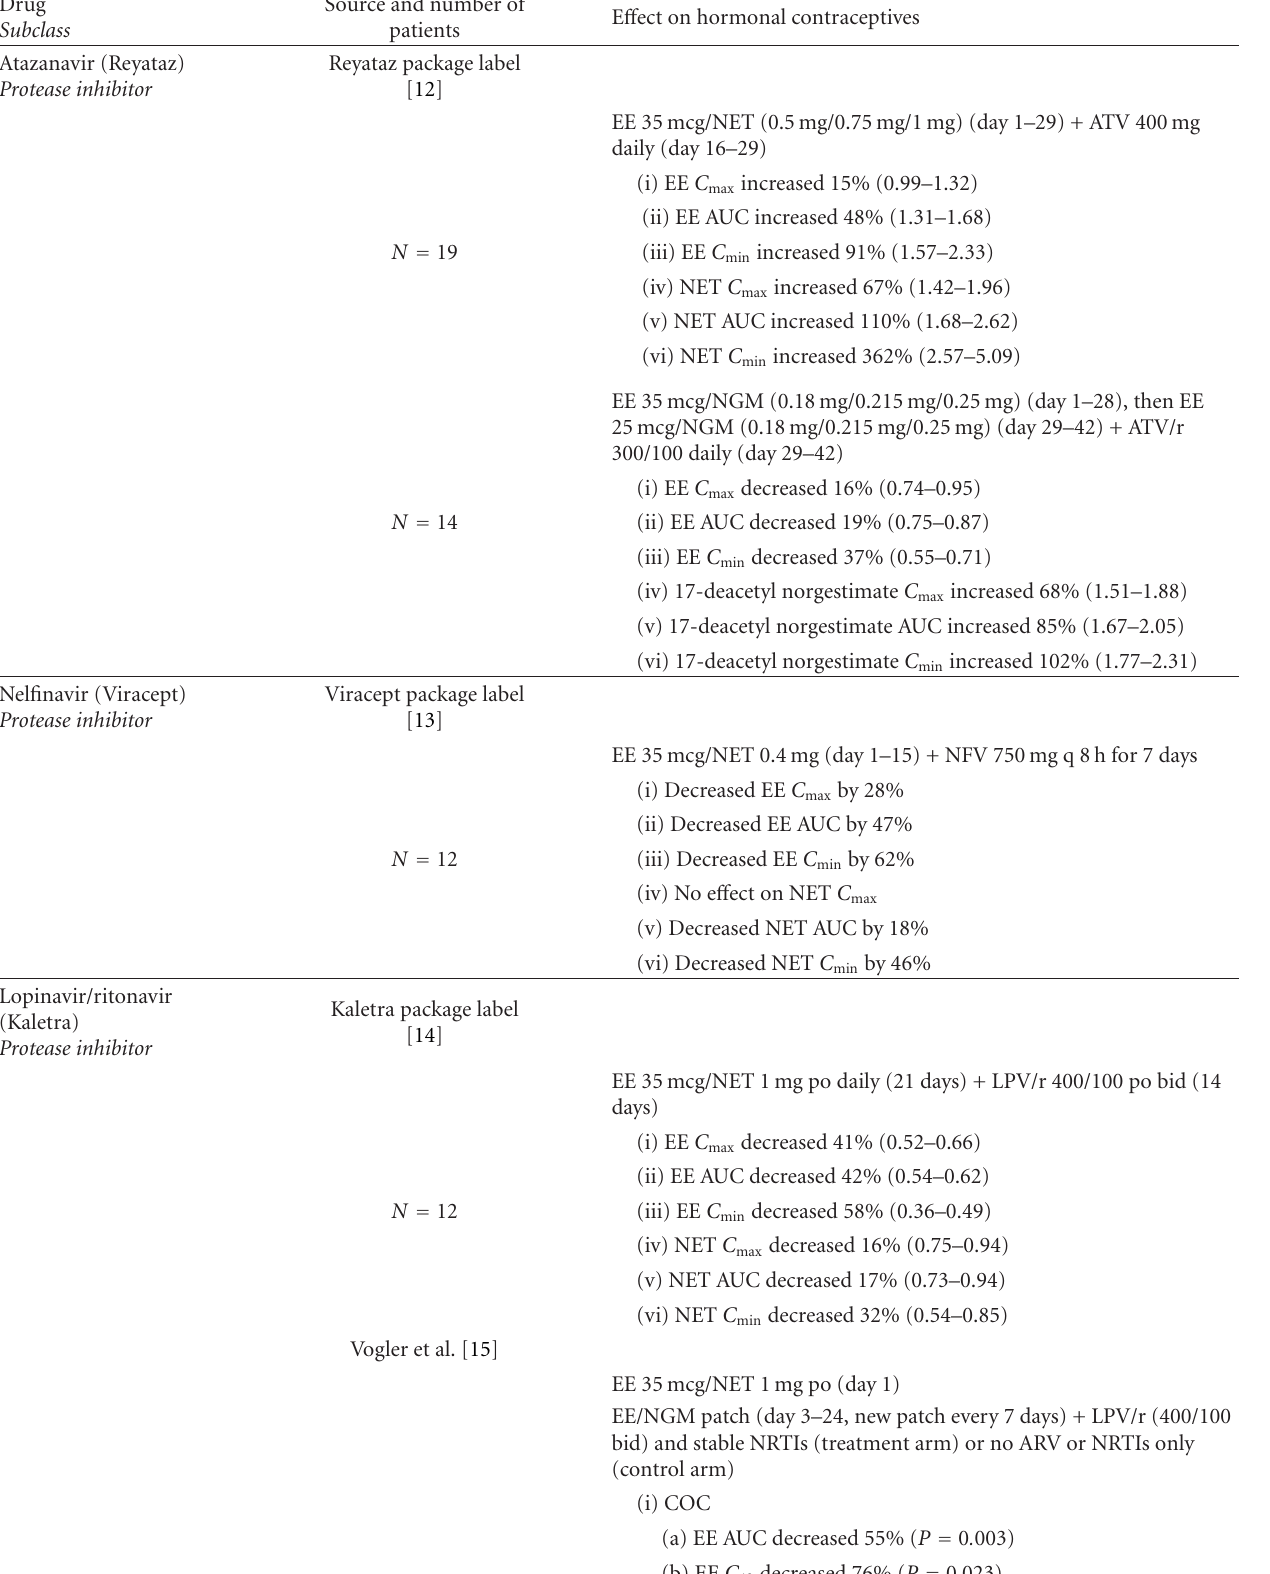
Table 2: Summary of pharmacokinetic interactions (results are given as geometric mean ratios of HC + ARV to HC alone, with 90% confidence intervals, unless otherwise